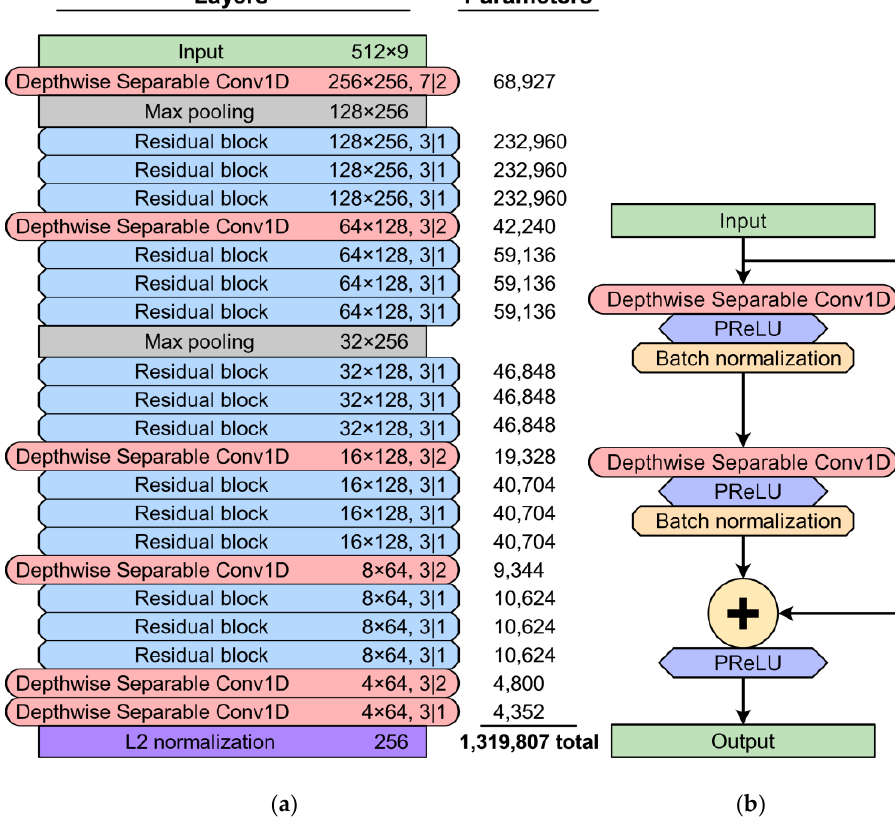
Figure 7. Diagram ( a ) depicts consecutive layers of the proposed neural network architecture. Each layer should be read according to the following schema: [layer_name output_shape filter_size|stride]. The last Depthwise Conv1D layer has an output shape of 4 features, 64 channels, filter size of 3, and stride 1. Diagram ( b ) shows the schema of the Residual block used as a layer type in ( a